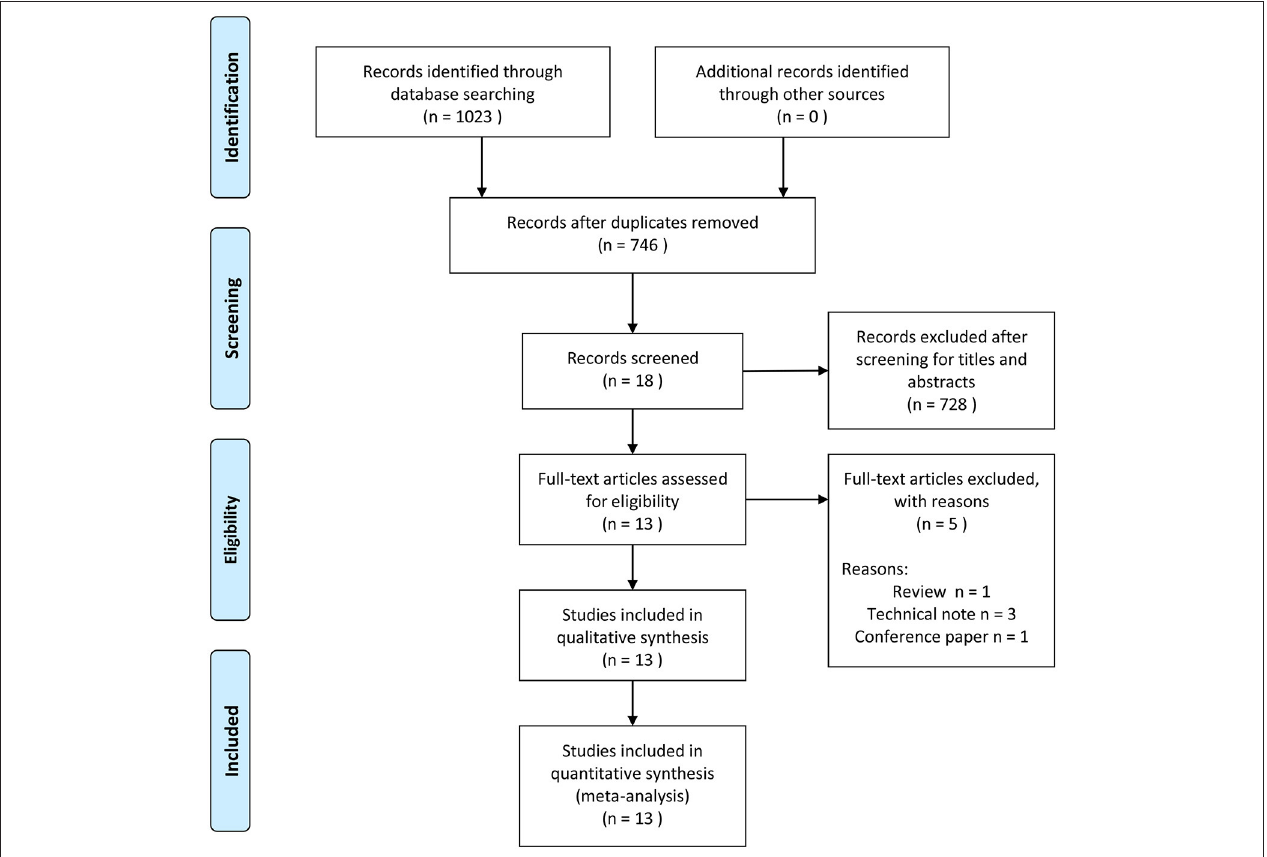
FIGURE 1 | Flowchart for study